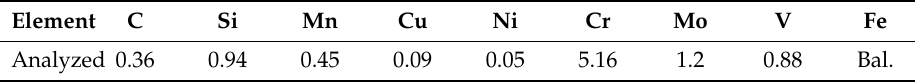
Table 1. Chemical composition of H13 steel (wt